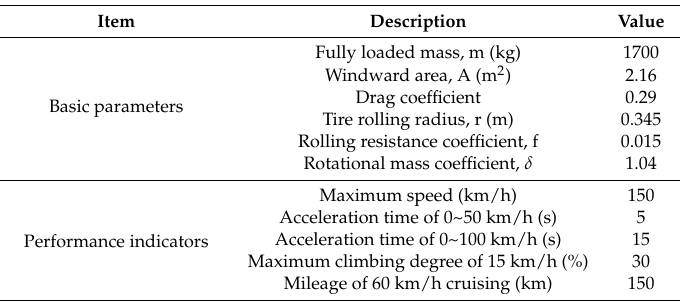
Table 2. Basic parameters and performance indicators of a pure electric vehicles (PEV) equipped with NDMPS.